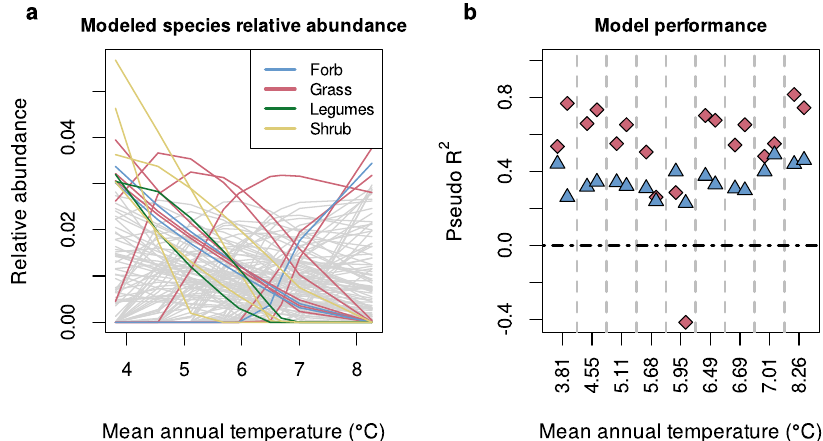
Fig. 2 Validation of the calibrated community model. a Modeled species relative abundances along the temperature gradient. The dominant species (able to reach a relative abundance of 0.03 in at least one community) are colored according to their functional group (forb in blue, grass in red, legumes in green and shrub in yellow), subdominant species are in gray. b Performance of the community model for each plot across the elevation gradient according to Nagelkerke pseudo R 2 . Red diamonds indicate the pseudo R 2 as predicted by the community model calibrated with the empirical functional traits. Blue triangles indicate the 95% quantile of the distribution of pseudo R 2 predicted by the null models. Negative values of the pseudo R 2 indicate cases where the likelihood of the model is lower than the likelihood of the hypothesis that all sampled species have equal relative abundance. For each model, pseudo R 2 values were calculated at the median of the posterior.